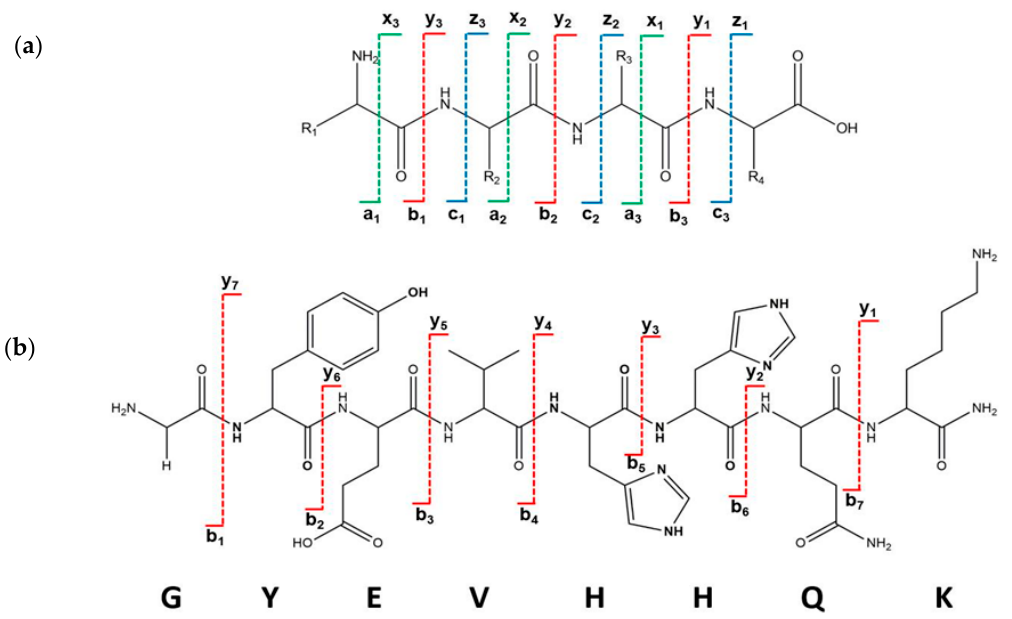
Figure 2. ( a ) Possible ion fragments which result in the collision-induced dissociation of the A β (9–16) peptide, of which some may appear in the MS / MS spectra; ( b ) the structure of b - and y -type fragment ions of the GYEVHHQK-NH 2